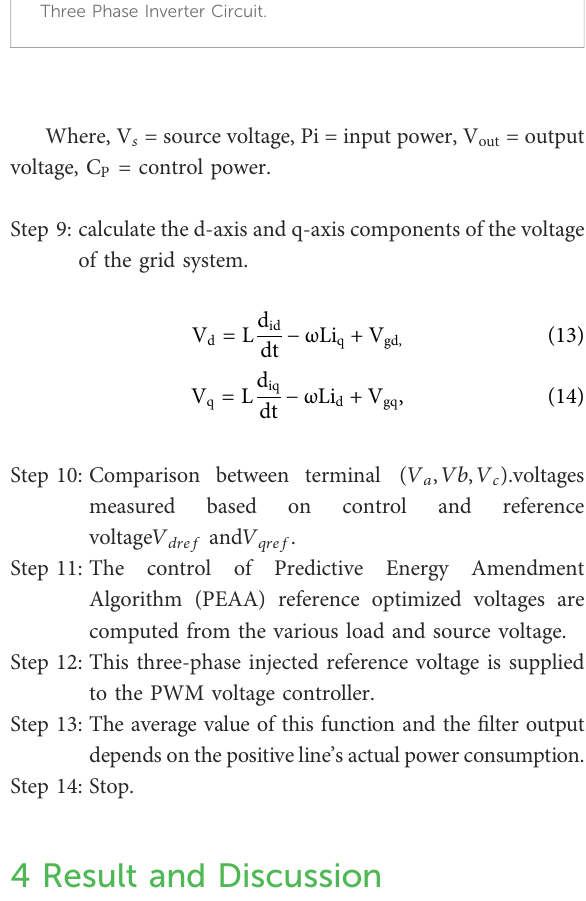
FIGURE 8 Three Phase Inverter